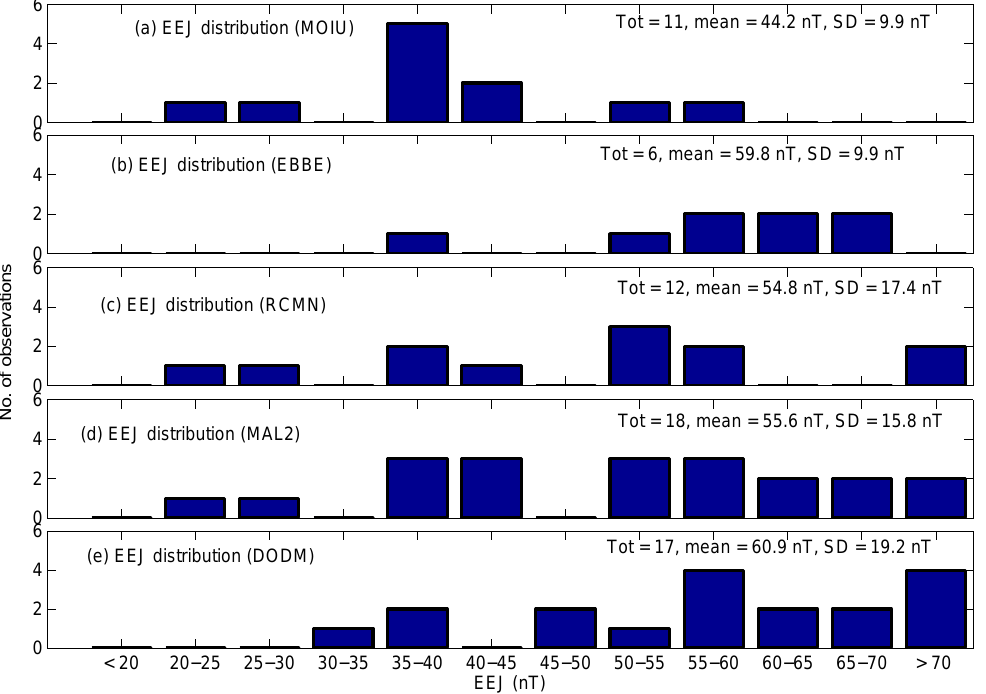
Figure 7. The distributions of EEJ strengths associated with prominent EIA at 14:00LT over (a) MOIU, (b) EBBE, (c) RCMN, (d) MAL2, and (e)